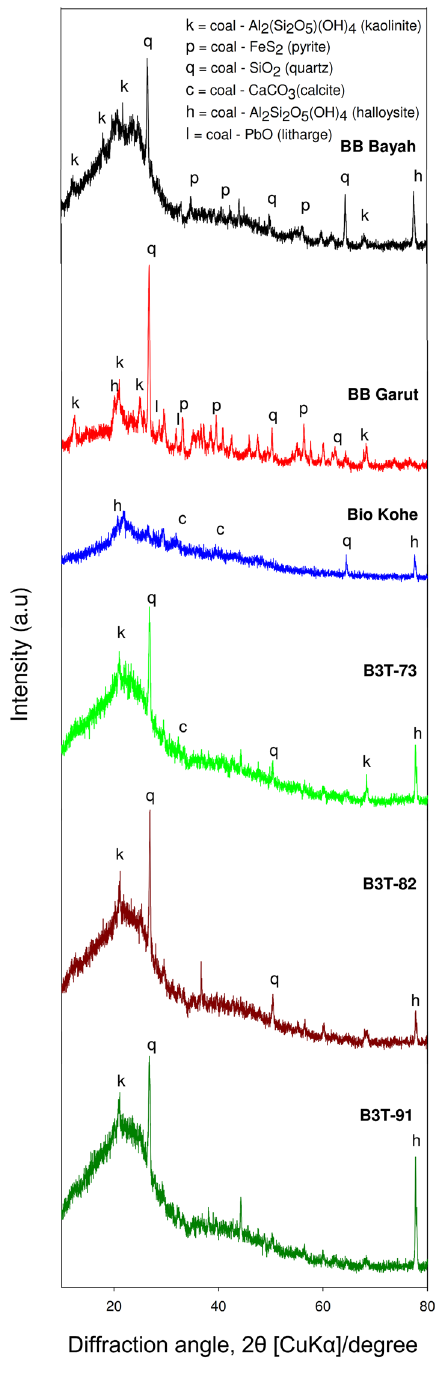
Fig. 2 Typical XRD profile of a low quality coal sample and bio-coal briquettes product